Question: What style of plot is this figure drawn as?
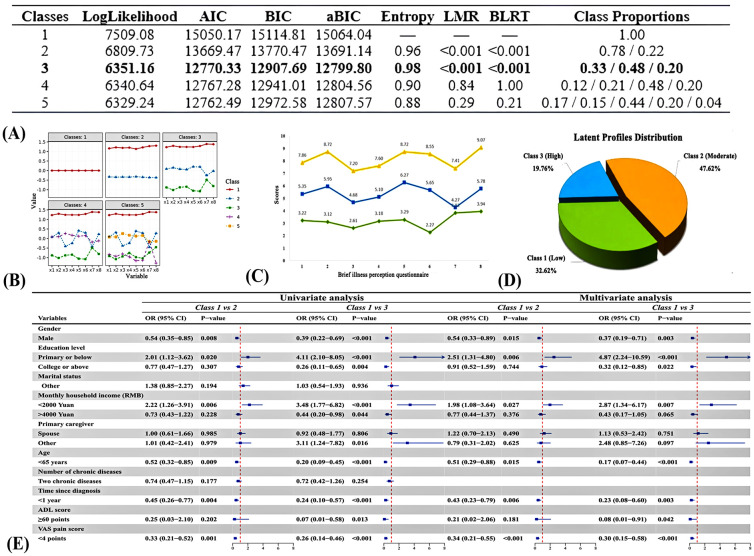
Answer: line